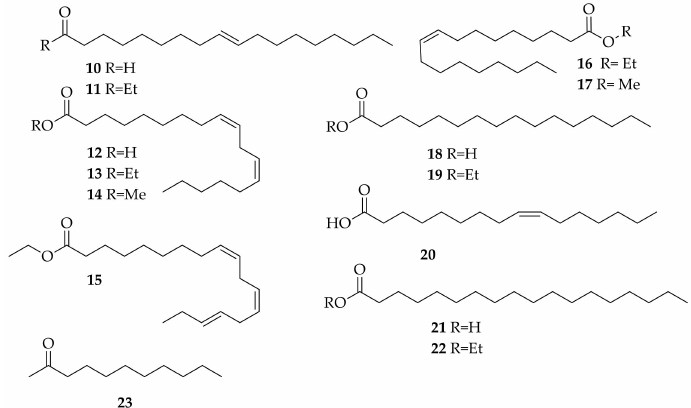
Figure 3. Structures of fatty acids: elaidic acid, ethyl elaidate, linoleic acid, ethyl linoleate, methyl linoleate, 9,12,15-octadecatrienoate ethyl ester, ethyl oleate, methyl oleate, palmitic acid, methyl palmitate, palmitoleic acid, stearic acid, ethyl stearate, undecan-2-one ( 10 – 23